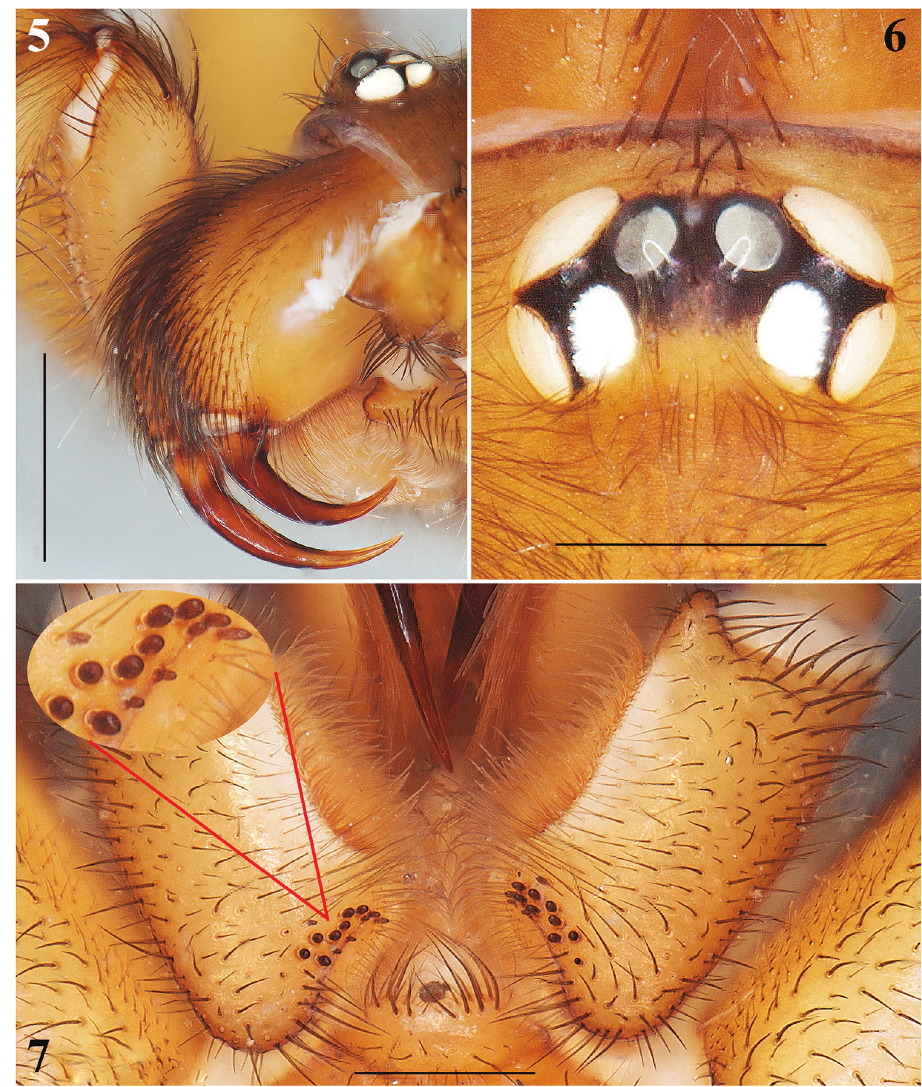
Figures 5–7. Aptostichus sabinae sp. n. Male holotype: 5 Chelicerae, lateral view 6 Ocular region 7 Endites, ventral view; detail of the cuspules. Scale bars 0.5 mm ( 6 , 7 ), 1 mm ( 5 ).